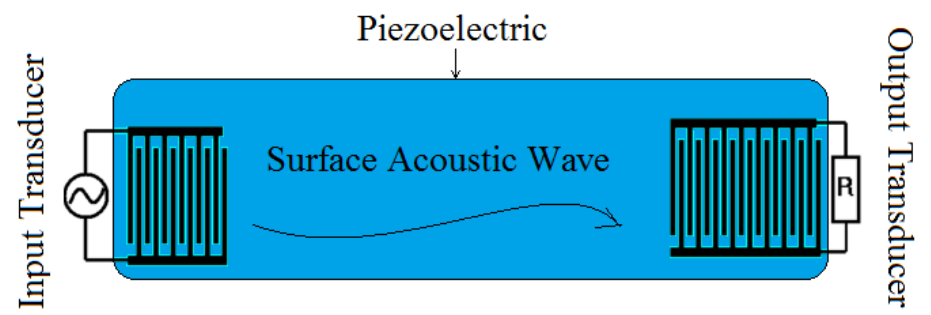
Figure 1. Top view of a typical of surface acoustic wave device, including input transducer, output transducer, and piezoelectric subtrace in a